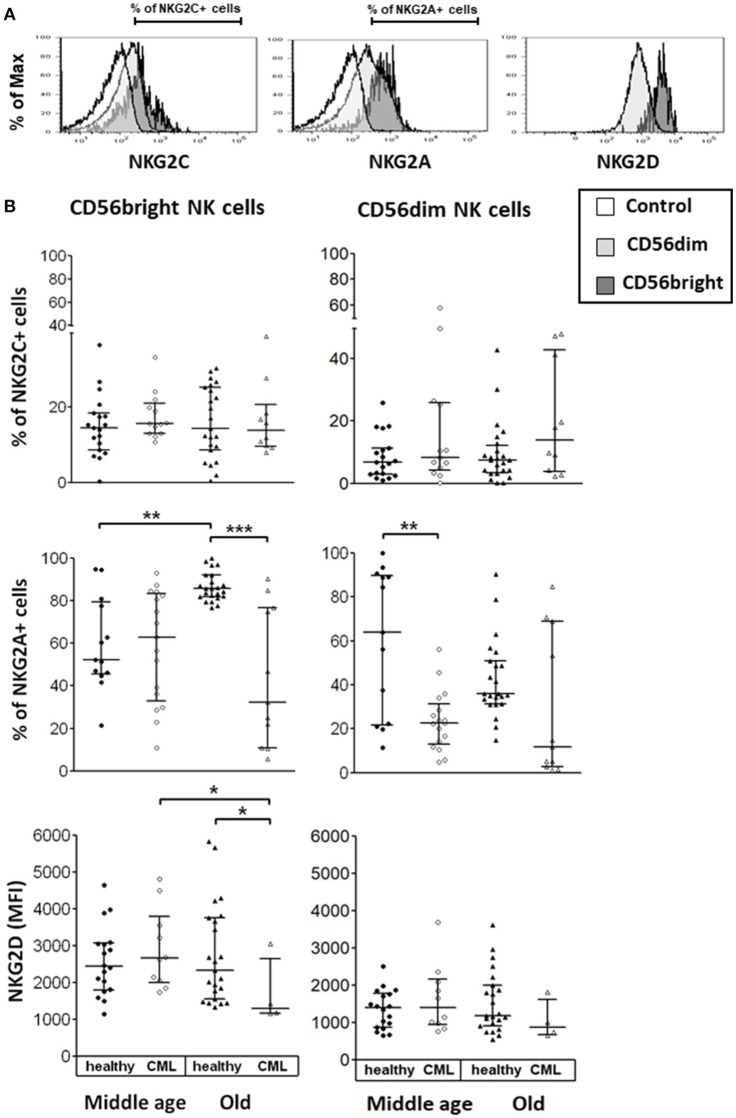
Expression of Natural Killer Group 2 (NKG2) receptors on NK cell subpopulations. (A) Representative histograms for each marker are shown (the non-shaded area represents the control, the shaded area of light gray, the CD56dim cells, the shaded one of gray, the CD56bright cells). The percentage of cells expressing NKG2C, NKG2A, and NKG2D as (MFI) measured in the total of cells, was determined on the surface of each subset by multiparametric flow cytometry. (B) Expression of activating receptors (NKG2C and NKG2D) and of inhibitory receptor (NKG2A) on CD56bright and CD56dim NK subsets from healthy individuals and TKI-treated CML patients, stratified according to age (middle-aged 35–65 years and old >65 years). Number of donors: NKG2C middle-aged healthy n = 19, middle-aged CML n = 13, old healthy n = 23, and old CML n = 10; NKG2D middle-aged healthy n = 18, middle-aged CML n = 10, old healthy n = 23, and old CML n = 4; NKG2A middle-aged healthy n = 13, middle-aged CML n = 17, old healthy n = 23, and old CML n = 11. The results, expressed as median with interquartile range, were considered significant at p < 0.05. P-values were determined comparing middle age with old and healthy with TKI-treated CML patients. *p <0.05; **p <0.01; ***p <0.001.